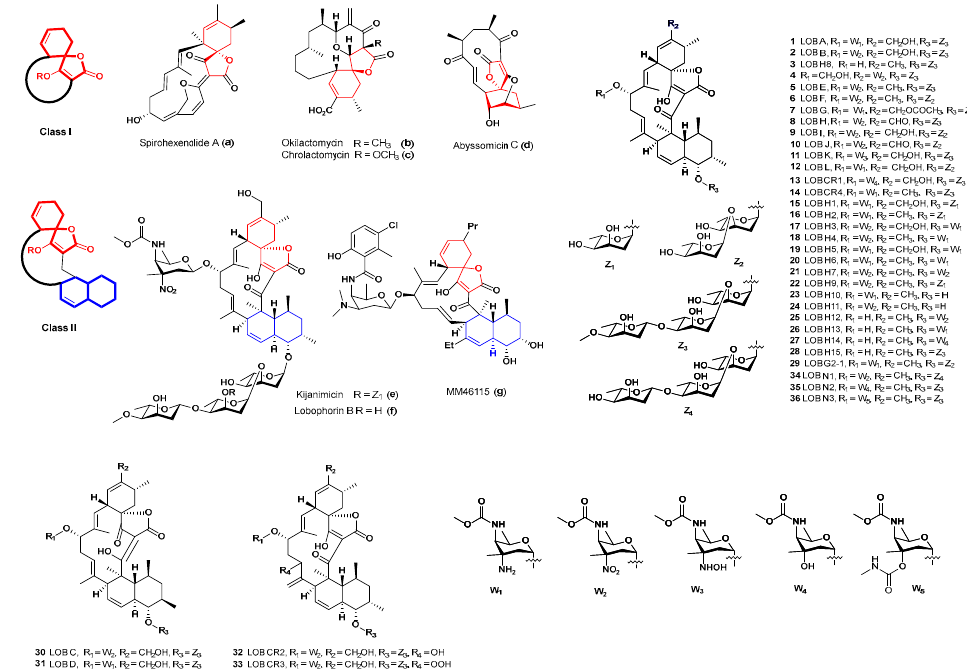
Figure 1. Selected representative spirotetronates and LOB derivatives.